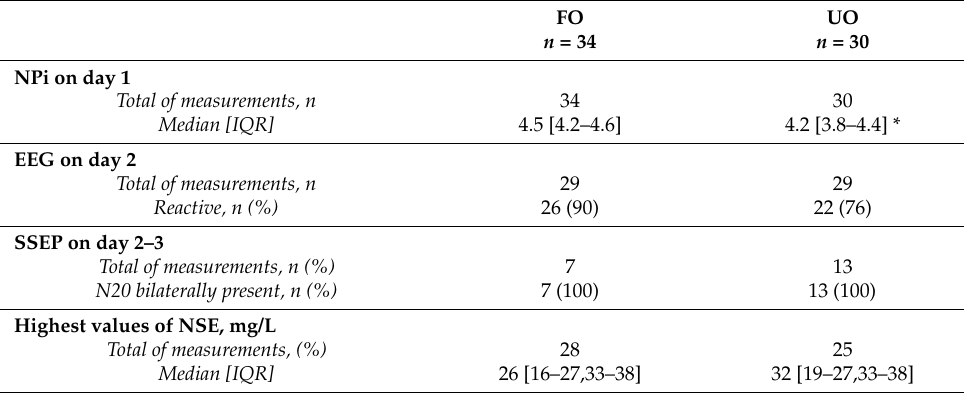
Table 3. Characteristics of patients ( n = 64) without predictors of unfavorable neurological outcome (i.e., abnormal NPi, highly malignant EEG patterns, high NSE and bilaterally absent N20). Data are presented as count (%) or median